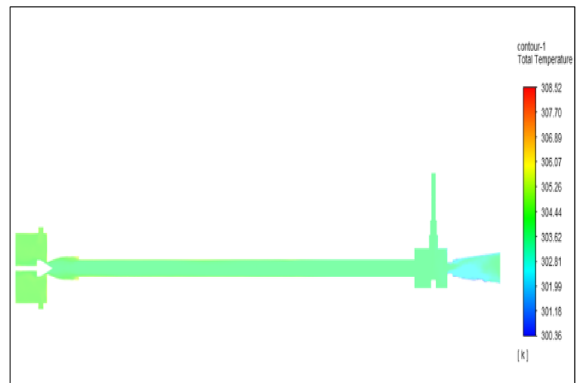
Figure 24. Nylon at 6 bar.